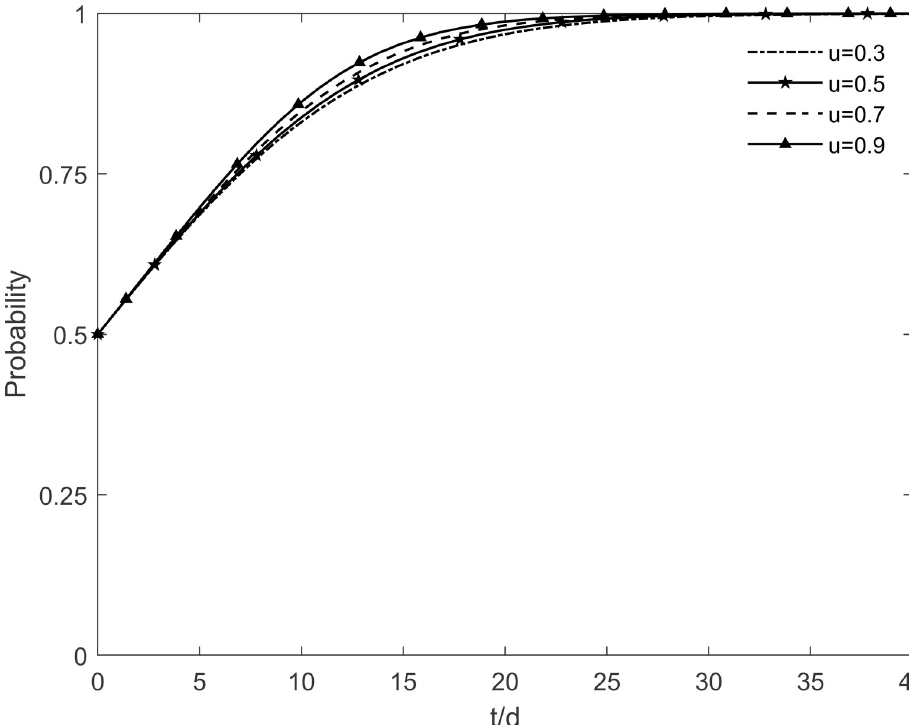
Fig 8. The impact of u on residents’ strategic choices.